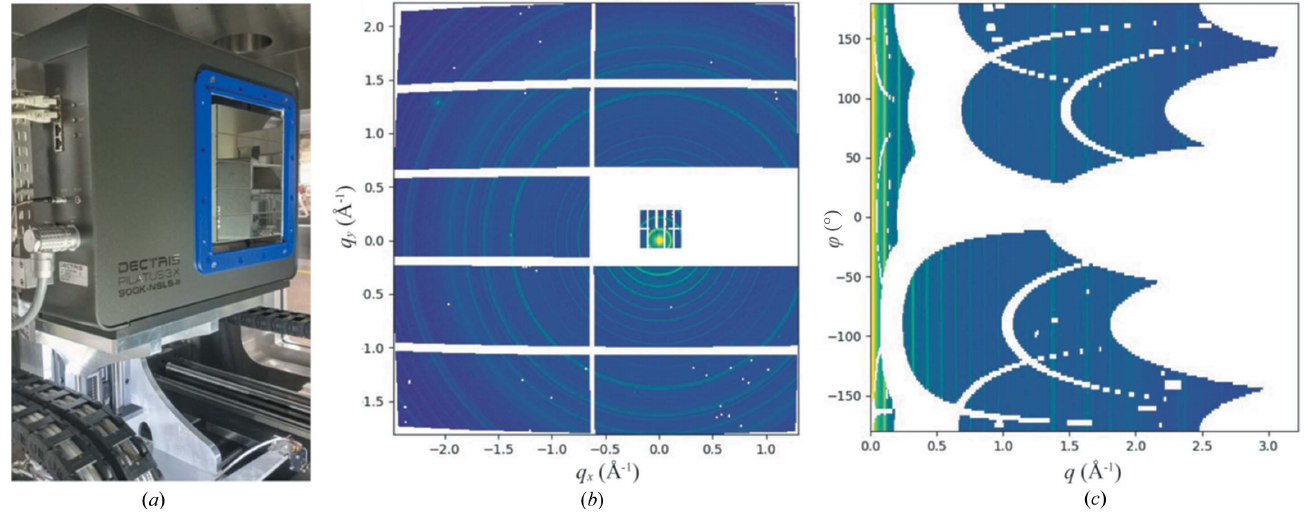
Figure 4 SAXS/WAXS data collection at LiX. ( a ) In-vacuum Pilatus 900k detector, located in the WAXS chamber downstream of the nosecone visible in Fig. 2( c ), for WAXS data collection. The SAXS detector is a Pilatus 1M and not shown. ( b ) SAXS/WAXS patterns collected from a silver behenate sample, shown as maps sharing the same reciprocal coordinates (in the plane perpendicular to the incident beam), after scattering intensity has been scaled between the two detectors. ( c ) The same scattering patterns can also be represented by intensity maps using the scattering vector q and the azimuthal angle ’ as